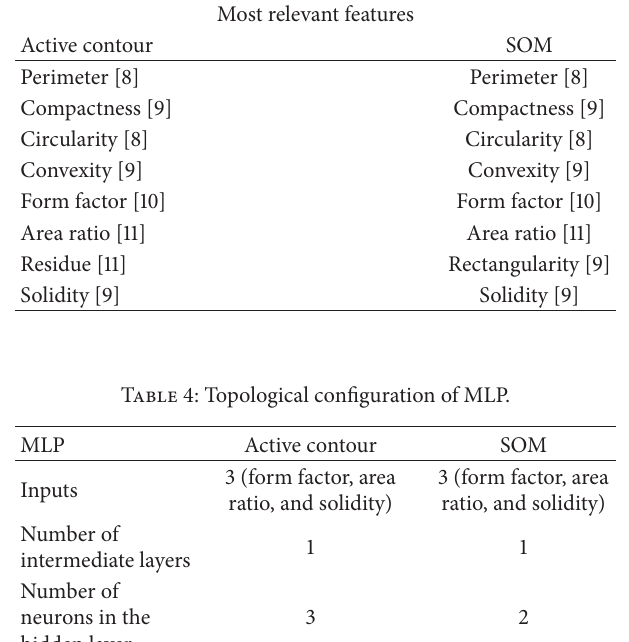
Table 3: The most relevant descriptors selected by Gaussian distri- bution curves for each segmentation method.